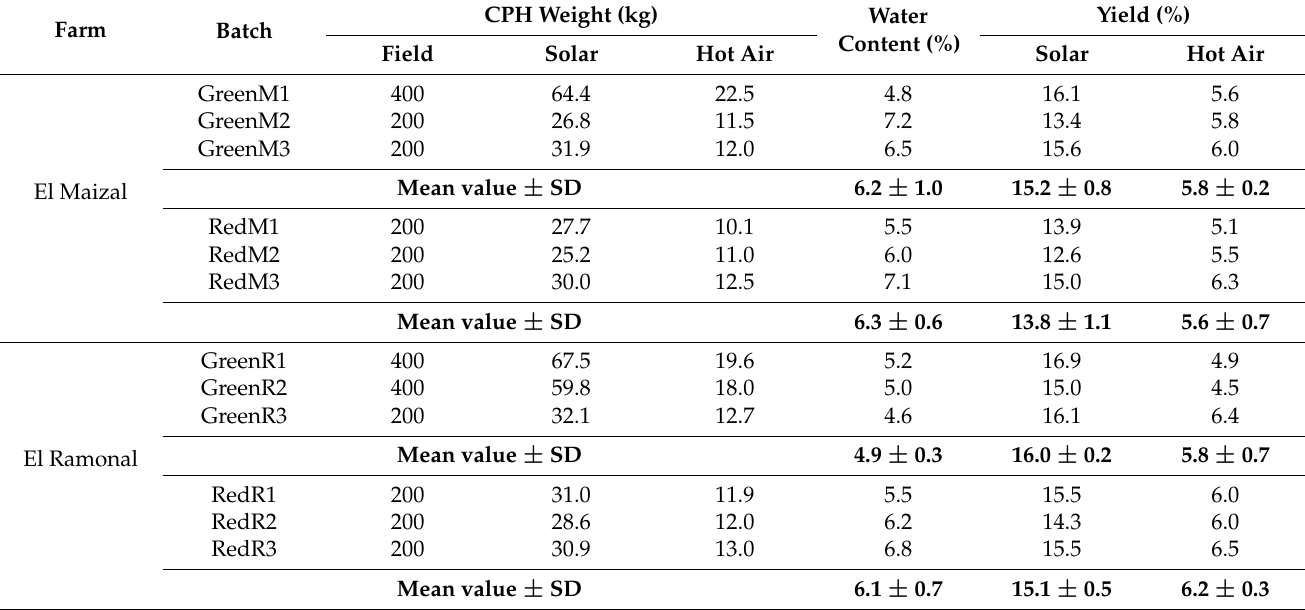
Table 5. Yield of cocoa pod husk and water content after drying.